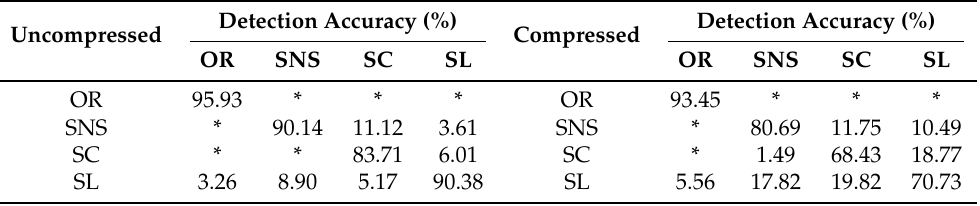
Table 3. CMOMTUI and CMOMTCI with